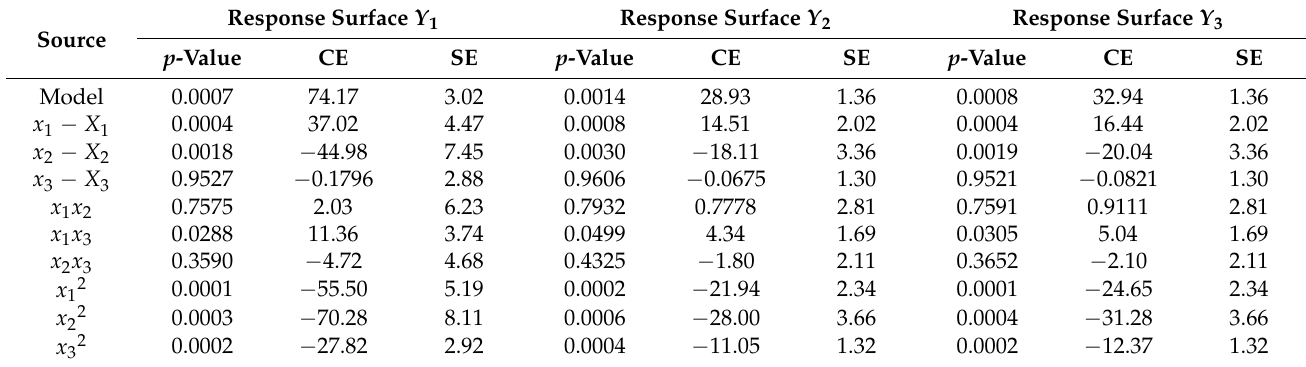
Table 3. The basic parameters of the response surface equation. Response Surface Y 1 Response Surface Y 2 Response Surface Y Source